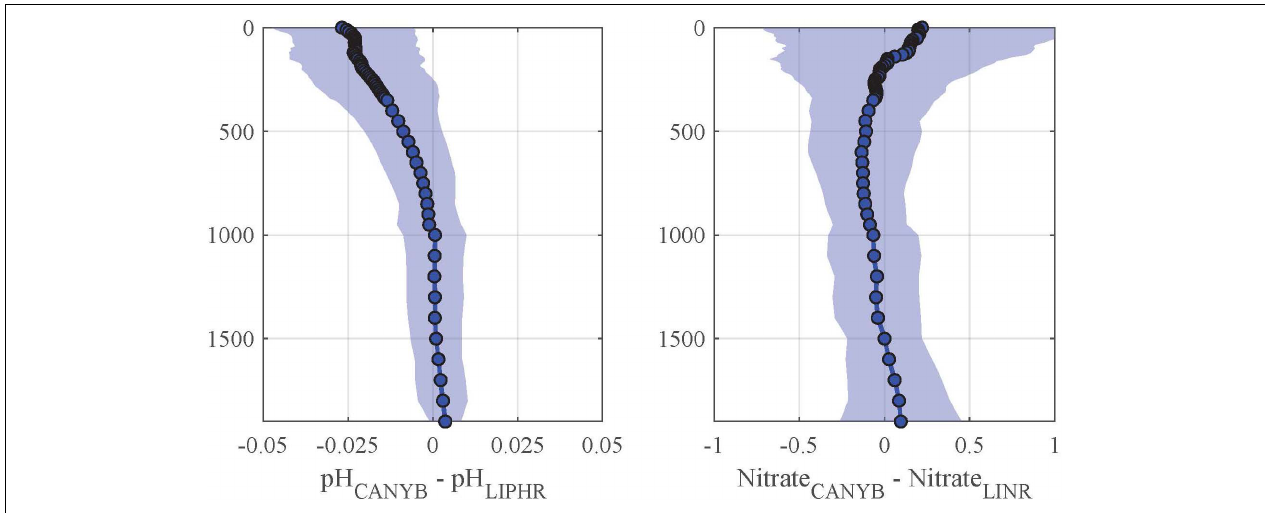
FIGURE 8 | Fleet-wide differences of computed pH (left) and nitrate (right) using CANYON-B and LIR algorithms. Data were binned at 10, 50, and 100 m pressure intervals for 0–350, 350–1000, and 1000–2000 db, respectively. The blue line represents the median difference and the shaded areas represent the interquartile